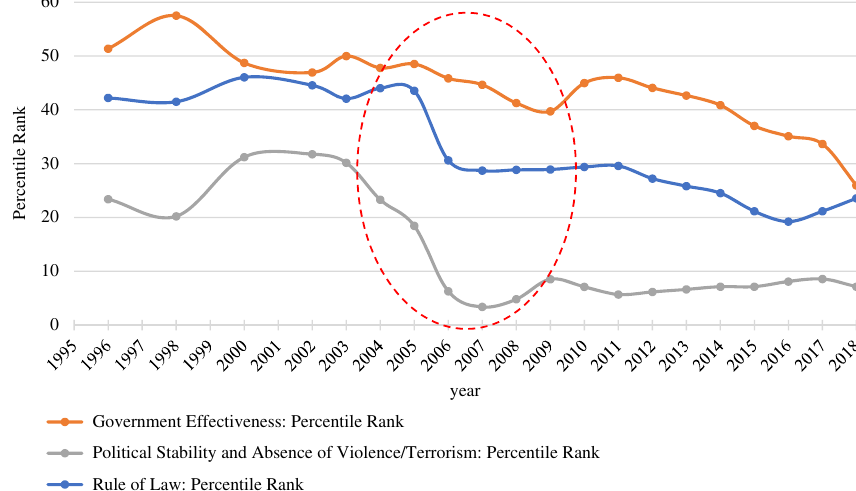
Fig. 2 Governance Indicators in Lebanon ( Source : World Bank Group